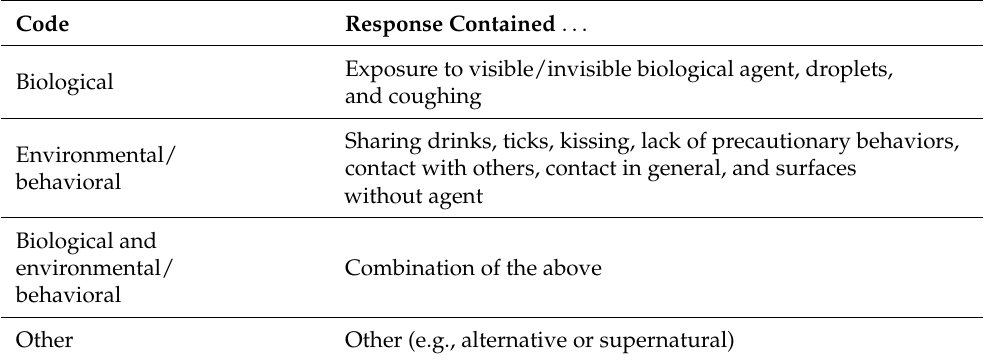
Table A2. Q4 (Transmission) “Can other people contract what (X) is suffering from? If so, how are they most likely to contract this condition?”.